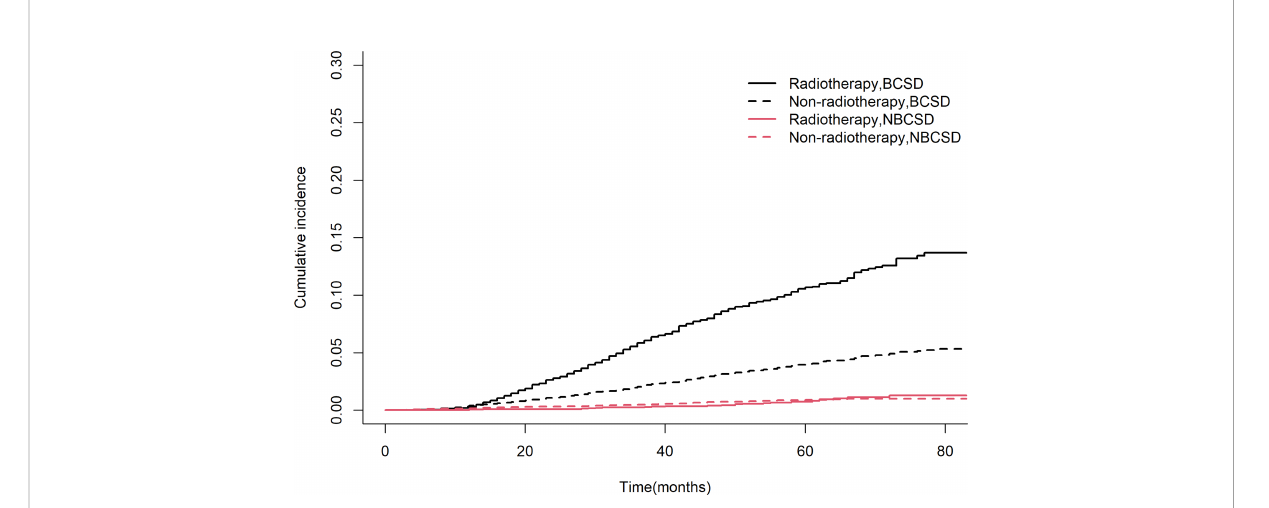
FIGURE 3 Competing risk models. BCSD, breast cancer-speci fi c death; NBCSD, non-breast cancer-speci fi c